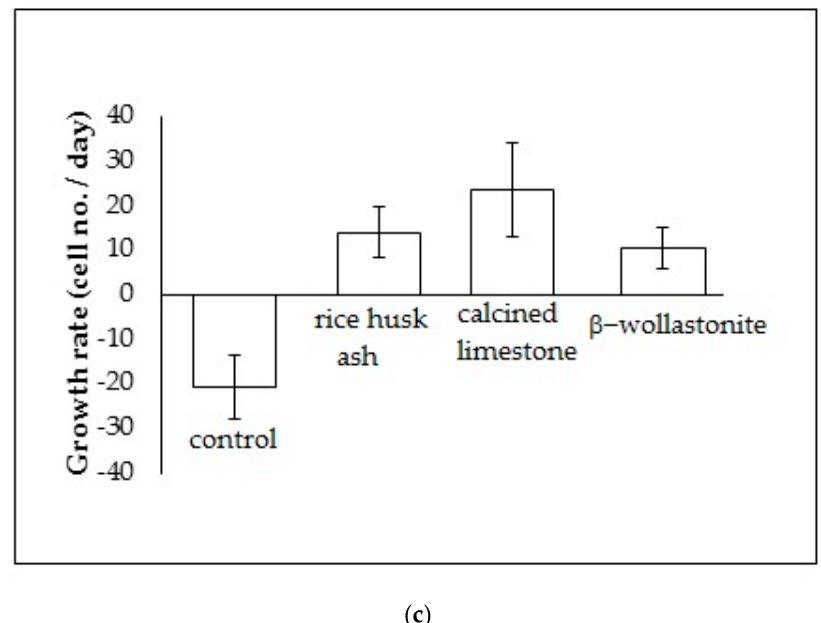
Figure 3. Cell viability test analyses show the; ( a ) reference curve for cell density on the culture dish; ( b ) cell distribution across different material discs; and ( c ) cell growth rates across the different material discs of rice husk ash, calcined limestone, and β -wollastonite powder samples for cell viability test.